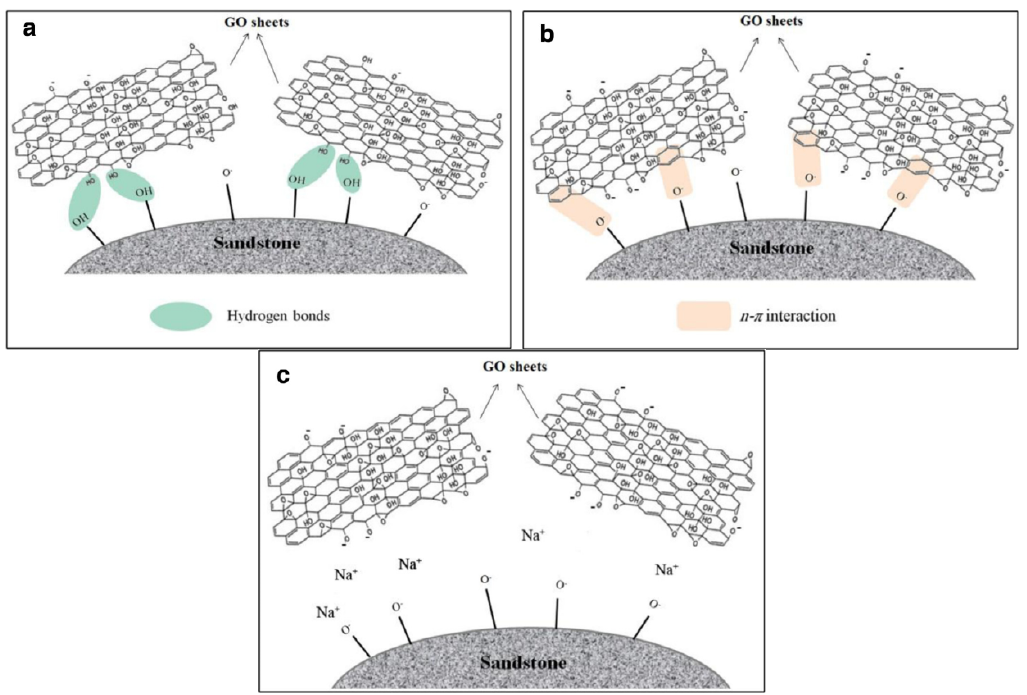
Figure 2. Schematic of adsorption mechanism of GO on sandstone at ( a ) low pH, ( b ) high pH and ( c ) at the presence of cations. (Reproduced with permission from [86]. Elsevier, 2017).